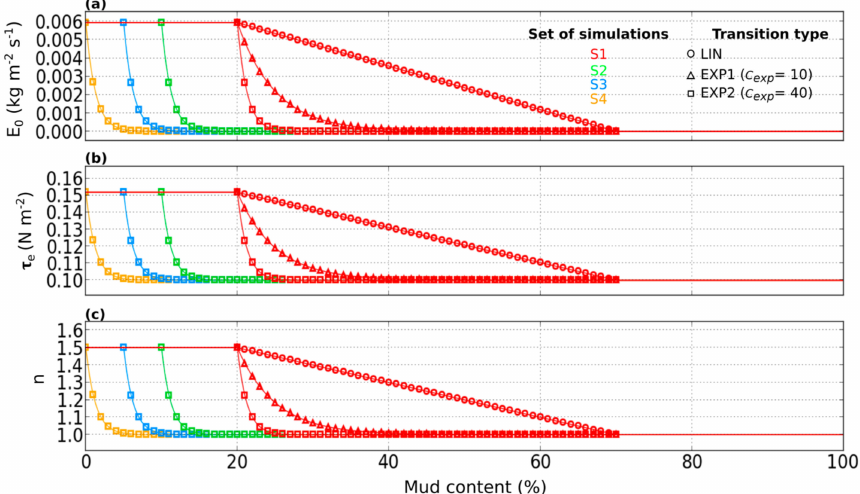
Figure 6. Variations in erosion-related parameters (erodibility parameter E 0 ( a ); critical shear stress τ e ( b ); and exponent n ( c ); used in the erosion law (Equation (1)) as a function of the surficial sediment mud content in the different erosion settings